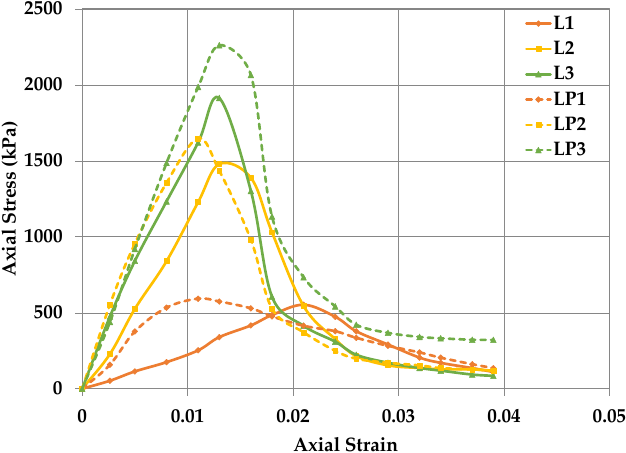
Figure 1. Stress-strain behavior of lime-stabilized soil with and without optimum PG content.